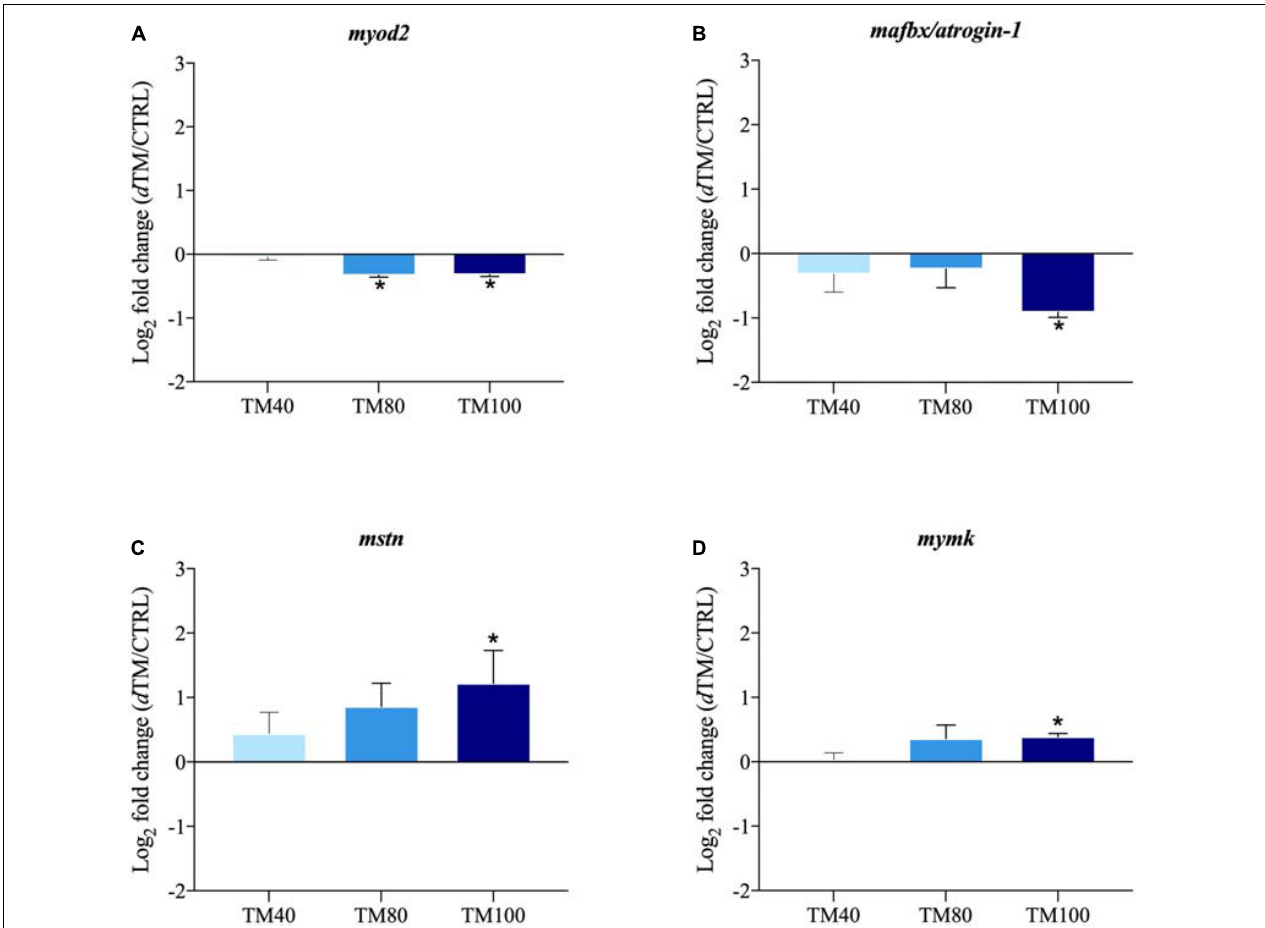
FIGURE 6 | Fold-changes ( d TM/CTRL) of differentially expressed genes in muscle tissue: myod2 (A) , mstn (B) , mafbx/atrogin 1 (C) , and mymk (D) . The asterisks indicate statistically significant differences (* p < 0.05; t-student) between European sea bass fed d TM and CTRL diets. Values > 1 indicate up-regulated genes in d TM fish; values < 1 indicate down-regulated genes in d TM fish. n = 9 (3